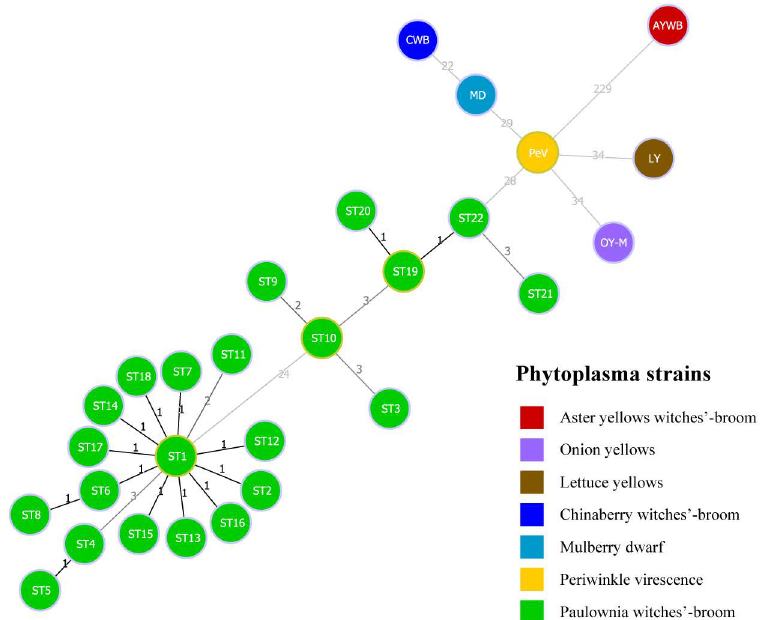
Figure 5. The population snapshot of PaWB phytoplasma strains and 6 kinds of phytoplasma reference strains, diagrammed based on a minimum spanning tree using goeBURST algorithm of PHYLOViZ 2.0 software, based on the concatenated sequences. Green circles represent 22 STs of 105 PaWB phytoplasma strains. The numbers above links represented the numbers of single- nucleotide polymorphisms (SNPs) between STs (including reference